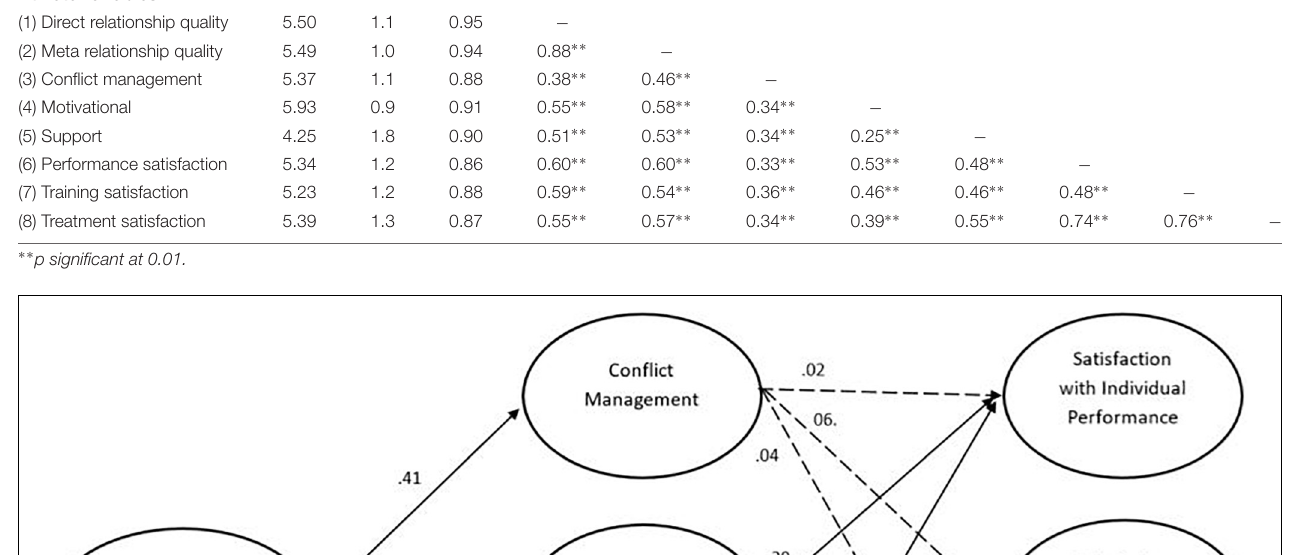
TABLE 1 | Descriptive statistics, Cronbach’s alpha coefficients and inter correlations for all main variables in the study. Variables M SD α Athlete variables